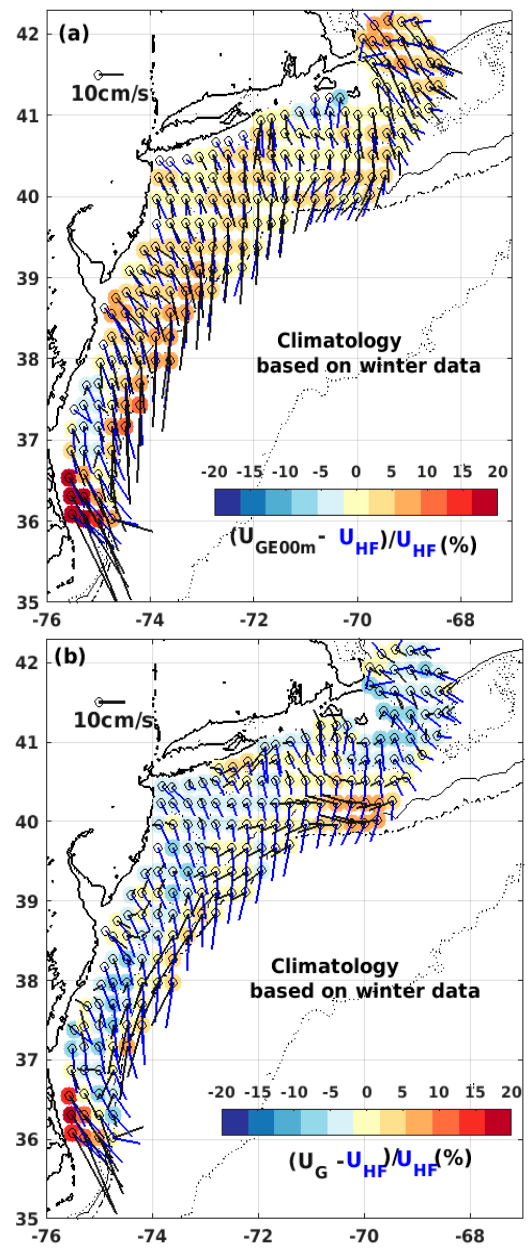
Figure 8. Same caption text as in Figure 7, but calculations are based on the winter data (December, January, and February).